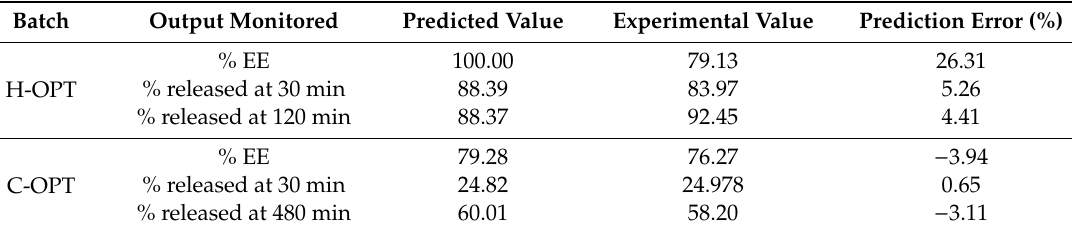
Table 6. Comparison of predicted and observed